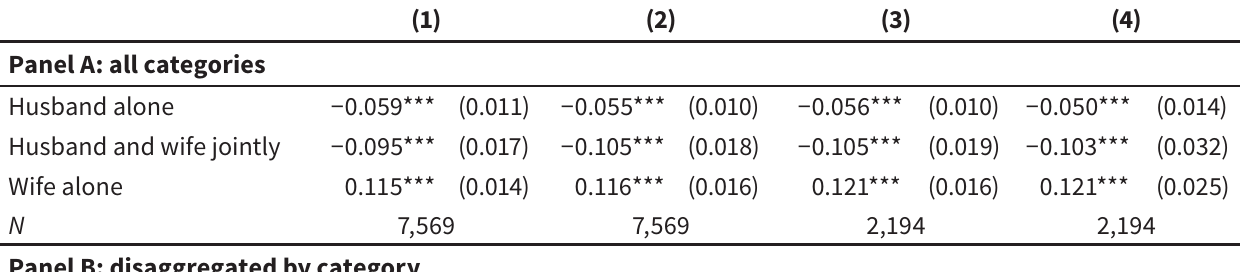
Shifts in decision-making power as the husband’s migrant status changes – only considering migration spells outside of Nepal and lasting >6